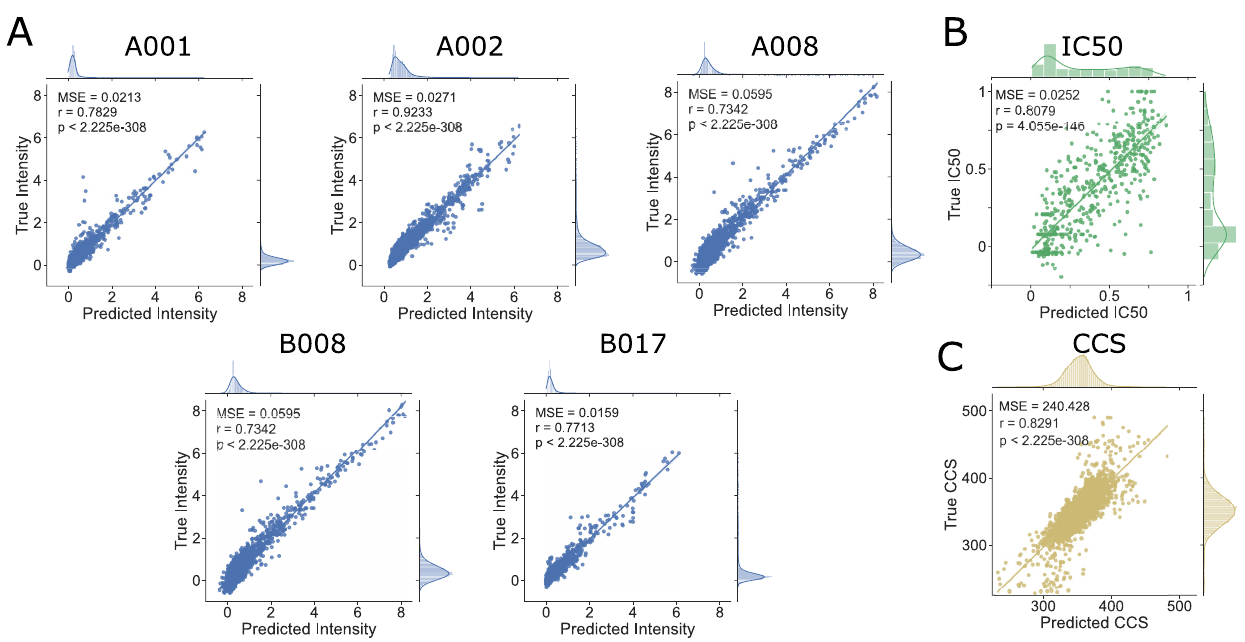
Fig 2. LSTM Model Performance. Held-out test peptides were input to the models and predictions were plotted against true experimental values. (A) For the Mamu allele multi-output regression model, predicted and experimental intensities were compared. (B) For the A � 11:01 model, predicted and experimental IC50s were compared. (C) For the collisional cross section model, predicted and experimental collisional cross sections were compared. For each model, predicted and experimental values were compared with the Spearman’s rank correlation and all demonstrated a significant (p-value < 1E-145) positive correlation (rho >